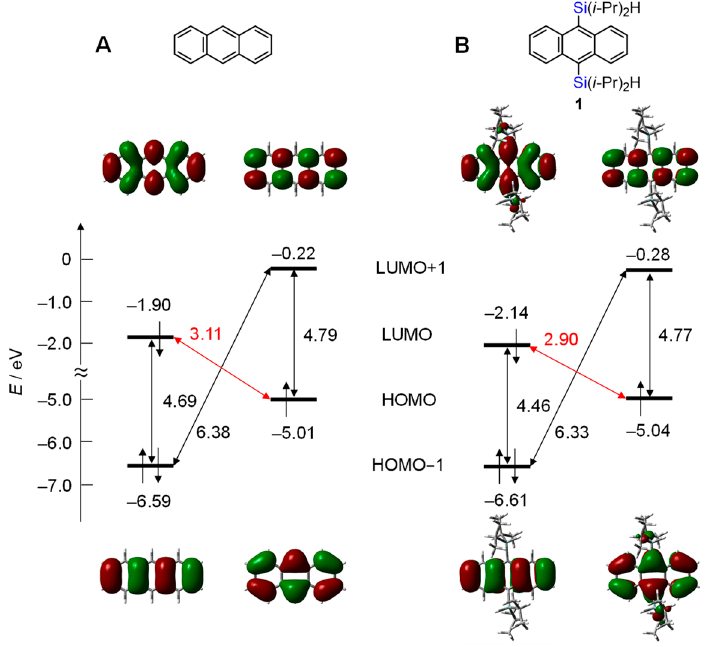
Figure 8. The HOMO, HOMO − 1, LUMO, LUMO+1 and their energy levels of the S 1 states of 1 ( B ) and anthracene ( A ) calculated at the B3LYP/6-31G(d) level.